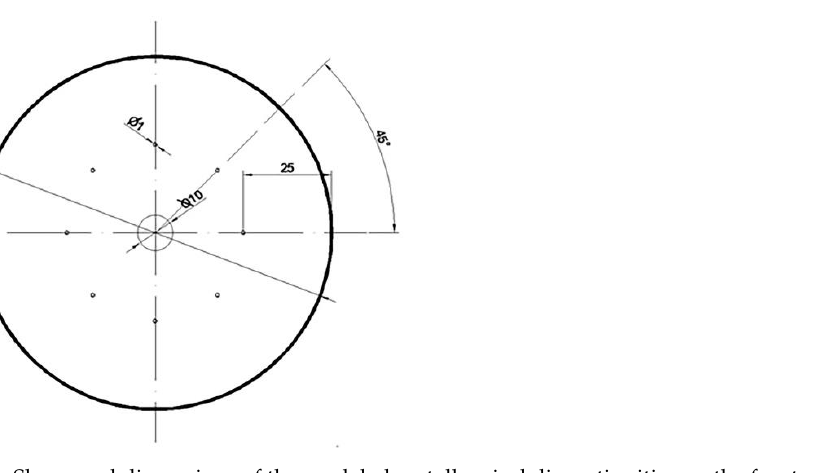
Figure 4. Shape and dimensions of the modeled metallurgical discontinuities on the front surface of the model zirconium alloy rod.